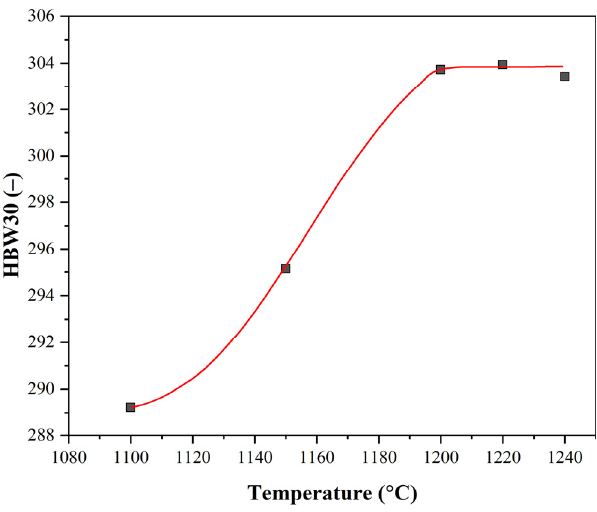
Figure 10. Average hardness of samples after quenching and tempering as a function of heating tem-